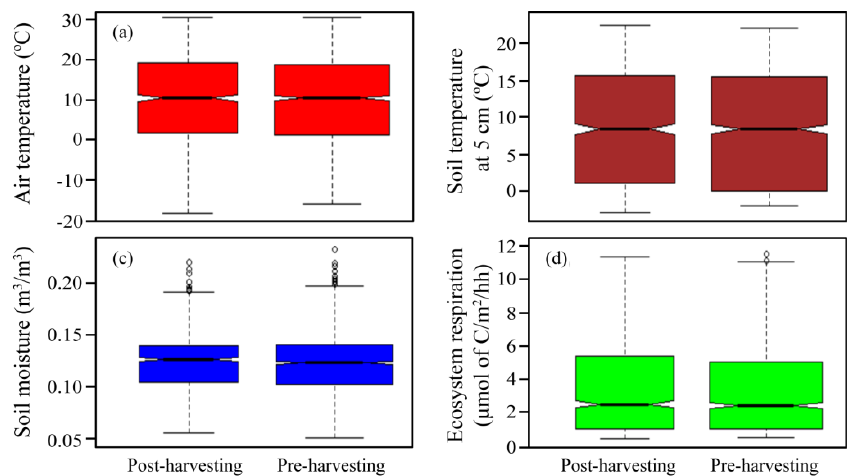
Figure 4. Comparison of half-hourly ( a ) air temperature, ( b ) soil temperature at 5 cm depth, ( c ) soil moisture averaged between 0 and 30 cm depths, and ( d ) ecosystem respiration pre- and